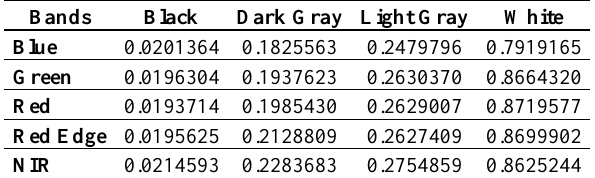
Table 2. Reflectance values of the spectral